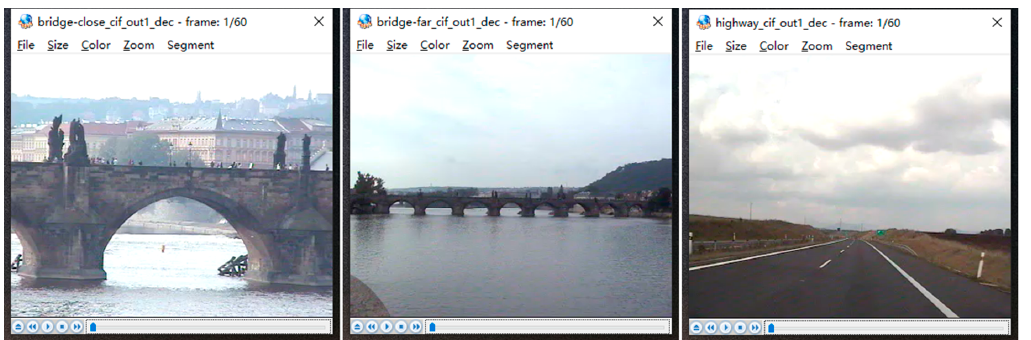
Figure 4. Video frame after embedding.